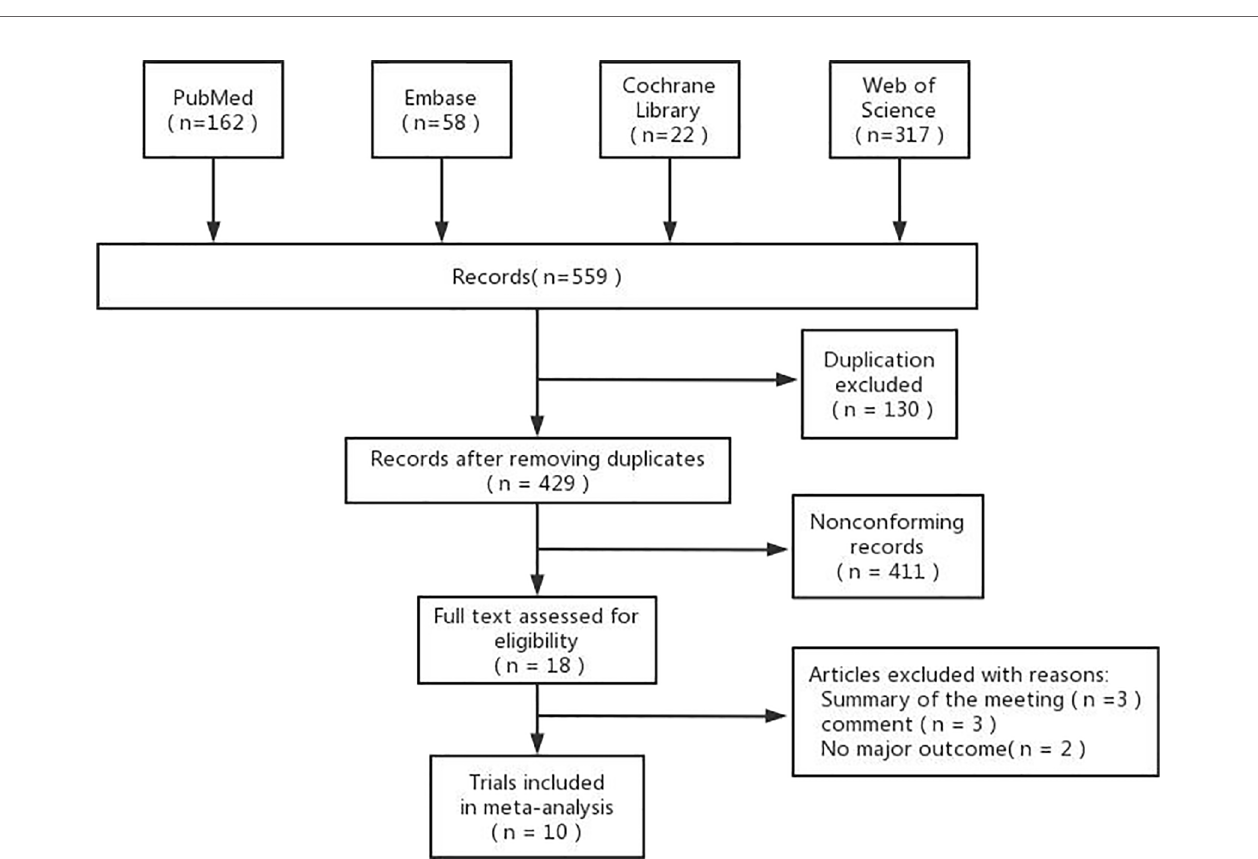
FIGURE 1 | Flowchart of study